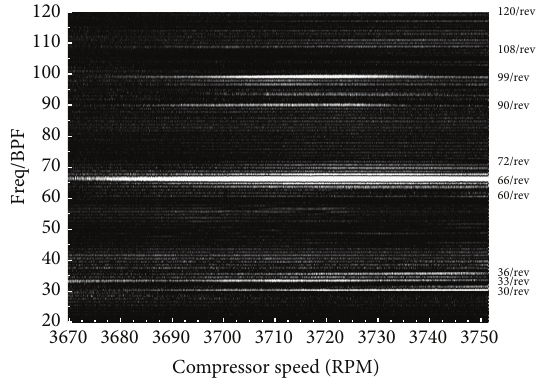
Figure 10: Waterfall graph at nominal loading.